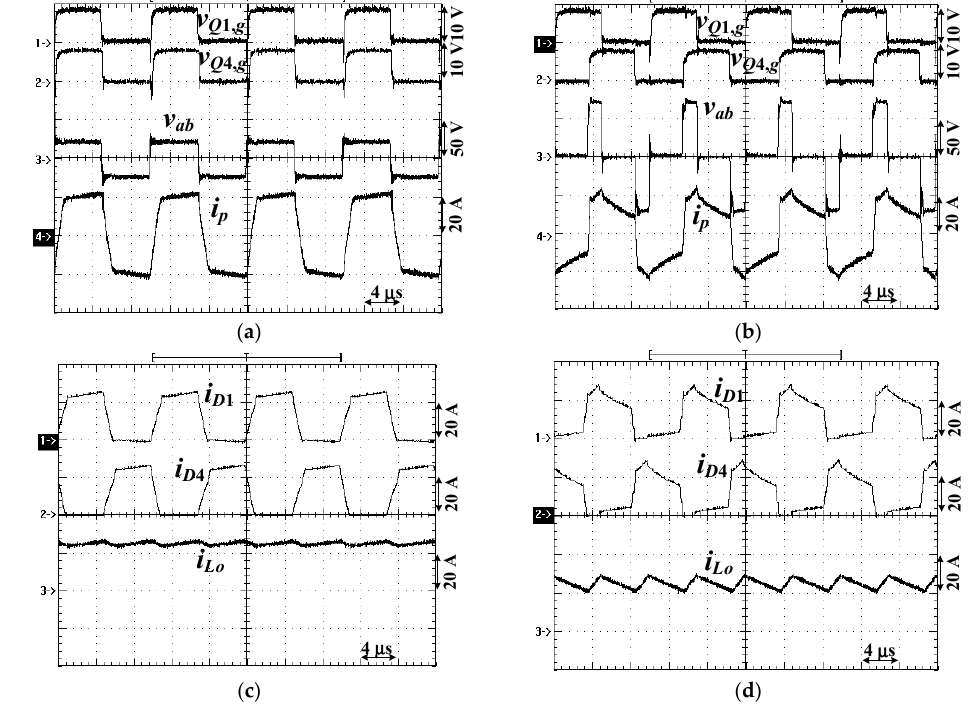
Figure 7. Experimental results in low input voltage range and full load ( a ) primary side waveforms at 25 V input ( b ) primary side waveforms at 75 V input ( c ) secondary side waveforms at 25 V input ( d ) secondary side waveforms at 75 V input.